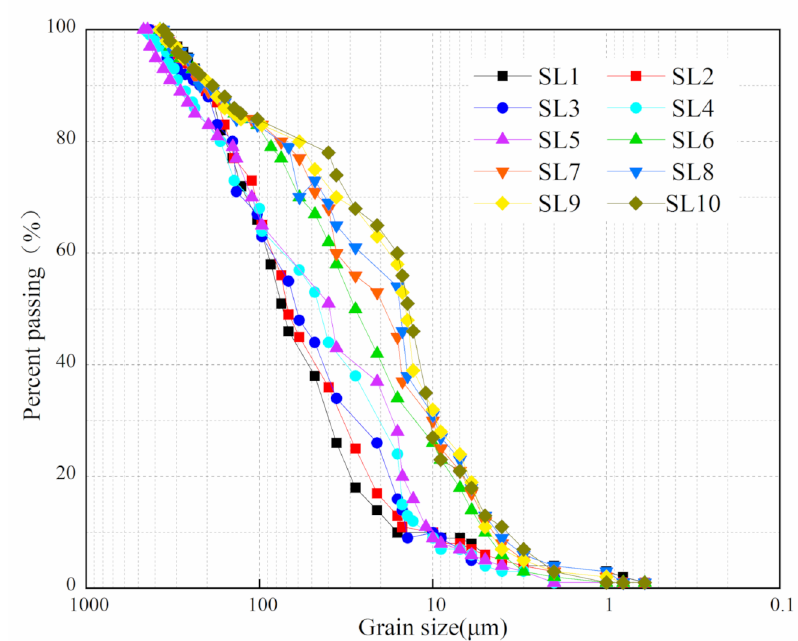
Figure 4. Grain size distribution of the slurry.